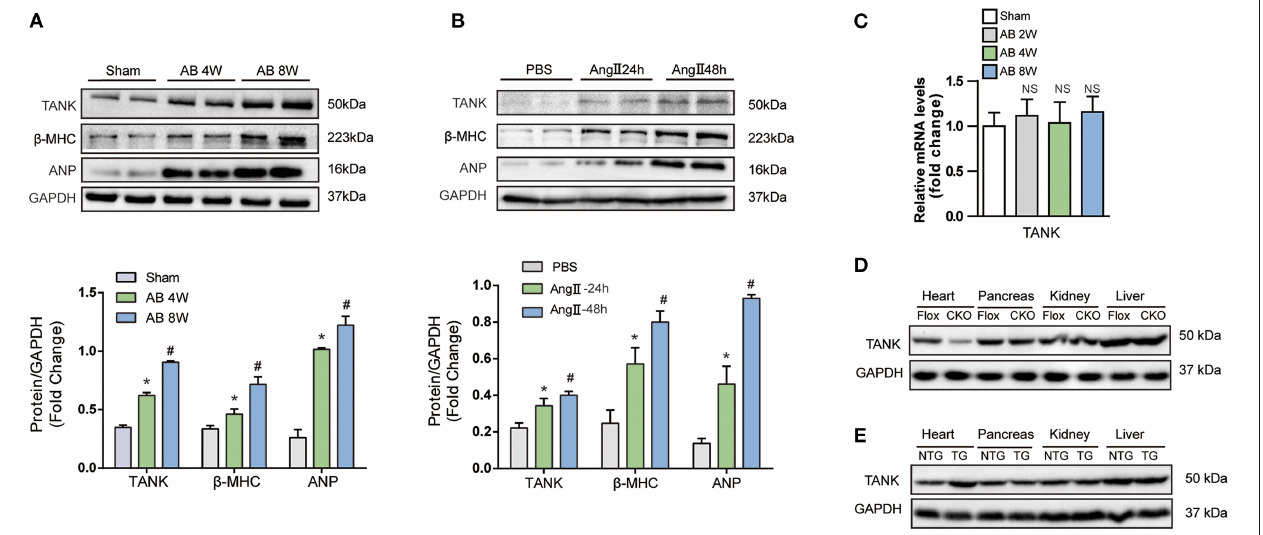
Frontiers in Cardiovascular Medicine |